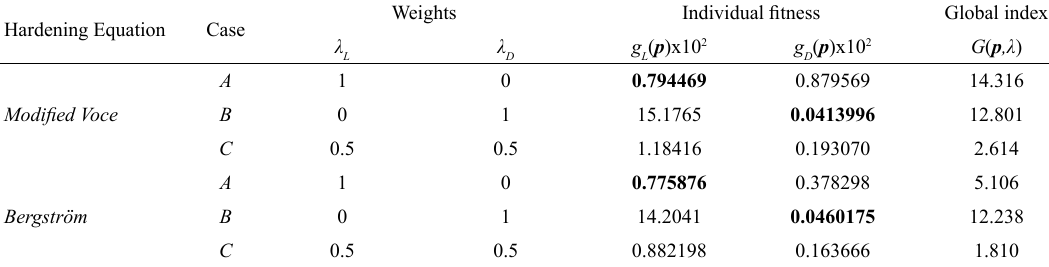
Table 4. Modified Voce and Bergström equations: best individual fitness(*) and global index. Hardening Equation